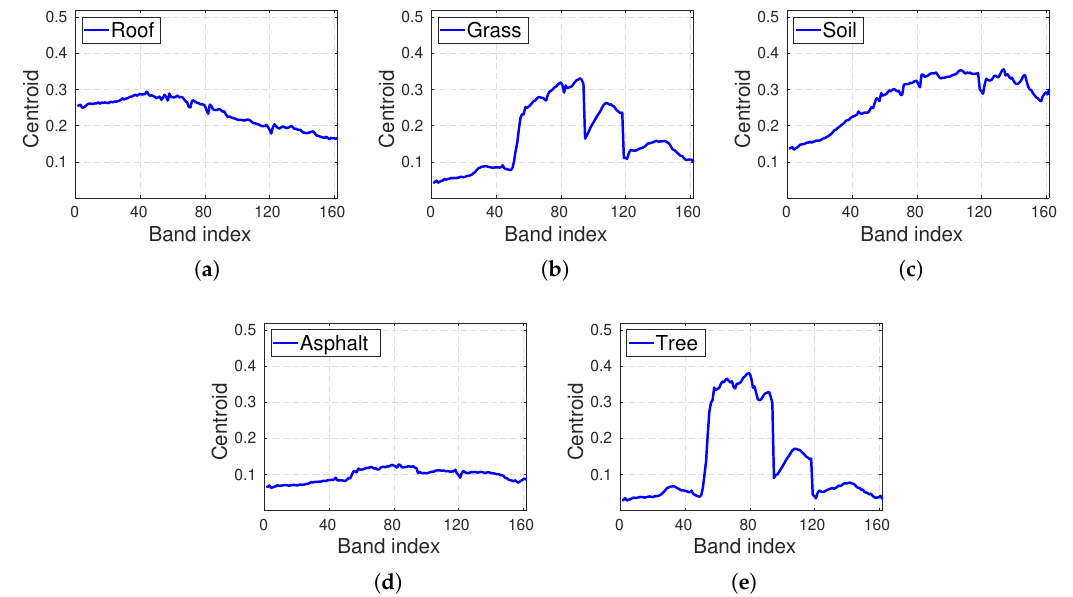
Figure 8. Cluster centroids of the partition of Urban with (cid:98) K = 5 clusters: ( a ) centroid of Roof; ( b ) centroid of Grass; ( c ) centroid of Soil; ( d ) centroid of Asphalt; ( e ) centroid of Tree.